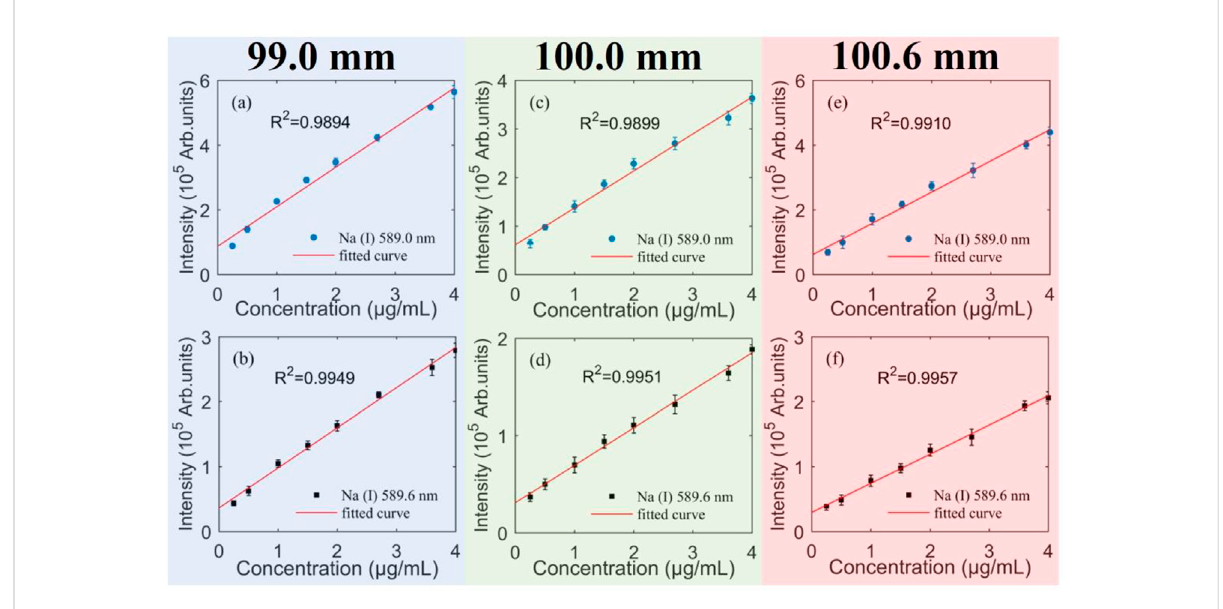
FIGURE 6 Calibration curves for Na ( Ι ) 589.0 nm (a, c, and e) and Na ( Ι ) 589.6 nm (b, d, and f) for three DFLSs. The DFLSs are 99.0 mm (A,B) , 100.0 mm (C,D) , and 100.6 mm (E,F) ,